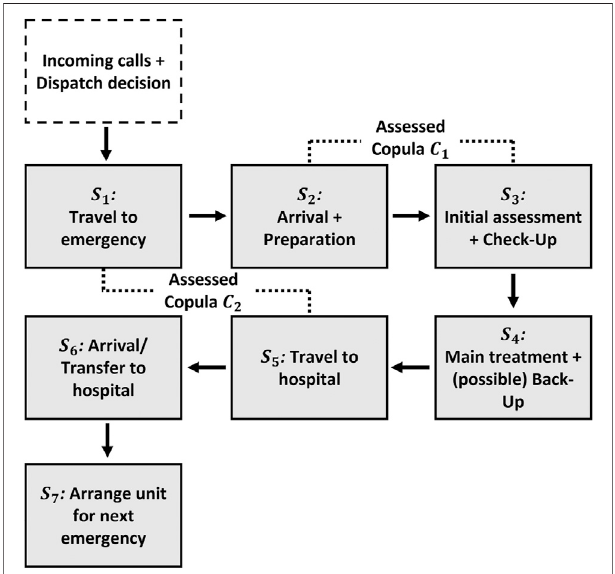
FIGURE 3 | Simulated ambulance service process